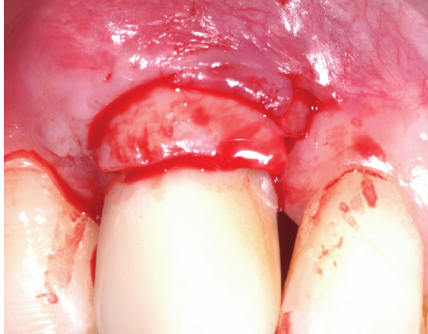
Figure 17: Detail of the epithelial half-moon coronal portion of the graft facing toward the prosthetic crown.